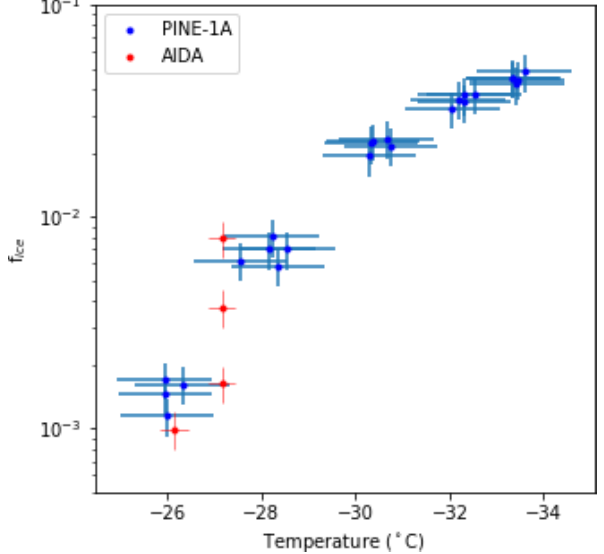
Figure 11. Ice-active particle fraction f ice measured with PINE- 1A (blue dots) for illite NX as a function of temperature (see also Fig. 10), in comparison to f ice measured in an AIDA (red dots) cloud expansion experiment with the same aerosol, right after the PINE-1A runs were